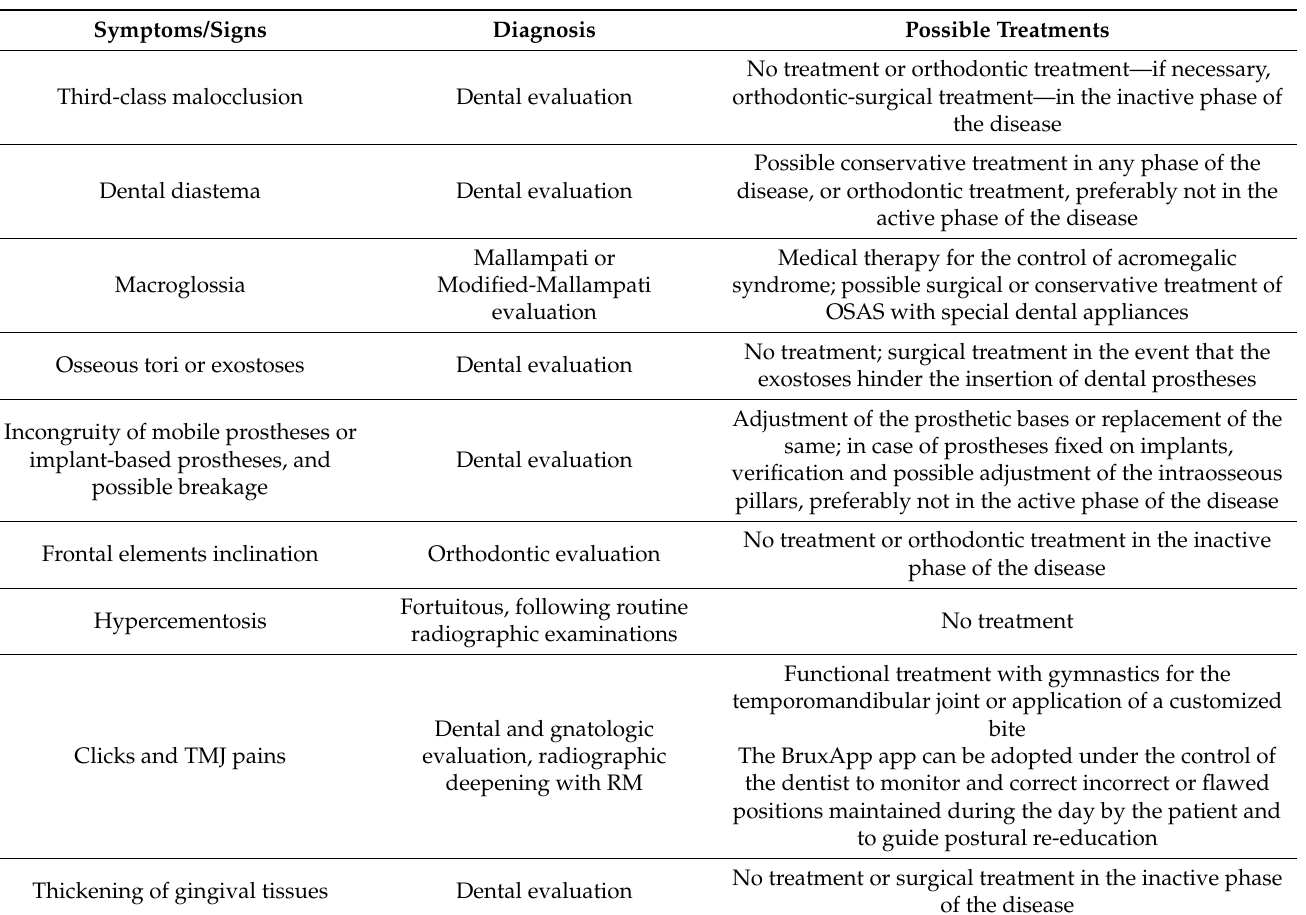
Table 1. Oro-maxillo-facial features of acromegaly and possible